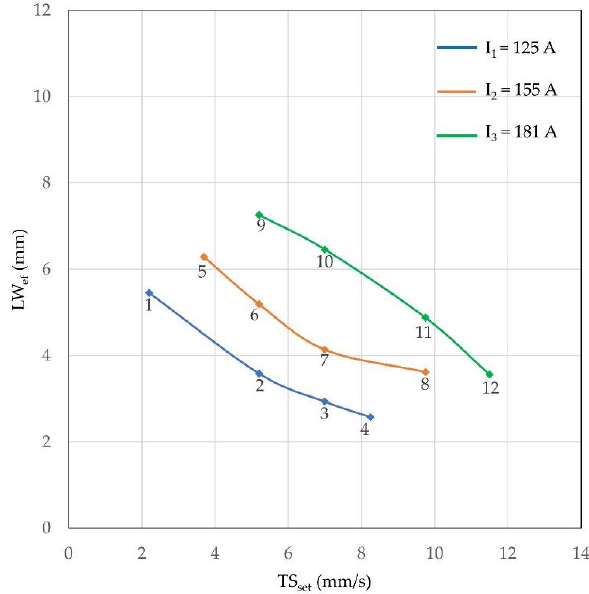
Figure 19. Minimal effective LW corresponding to the 12 experiments (correspondently numbered), according to the design for the experiments (the lumped area inside the Im and TS workable limits represents the working envelope).